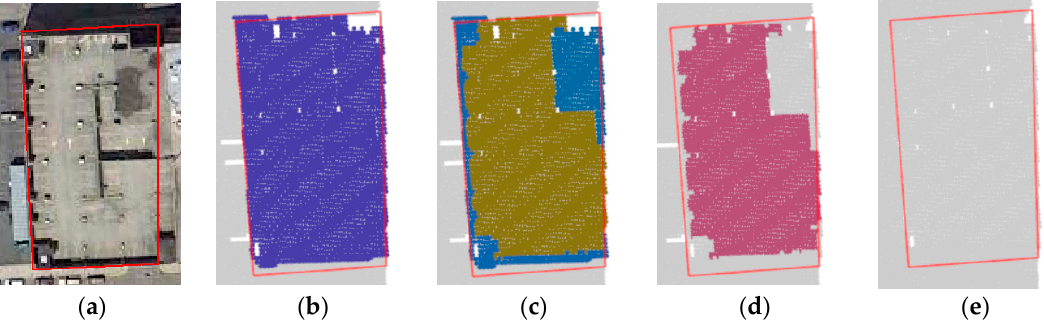
Figure 9. Evaluation criteria. ( a ) Reference building image; ( b ) correct detection; ( c ) over-segmentation; ( d ) under-segmentation; ( e ) missed.